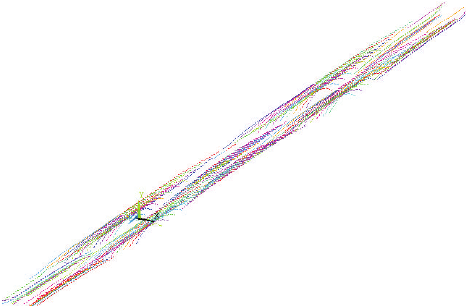
Figure 8: Finite element model of the prestressed steel